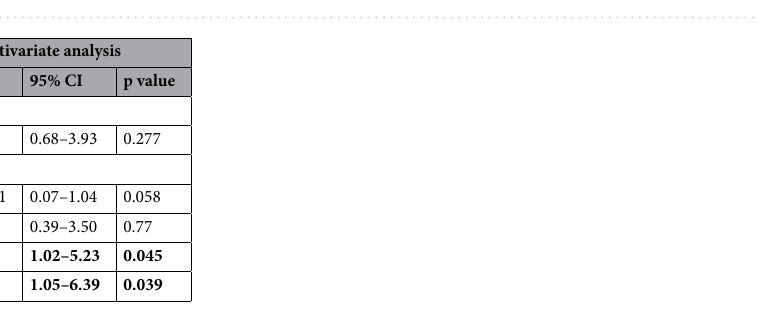
Figure 4. Representative positive immunohistochemical staining with c-Met ( a ), HGF ( b ), VEGFR2 ( c ) and CD31 ( d ) (original magnification × 200).